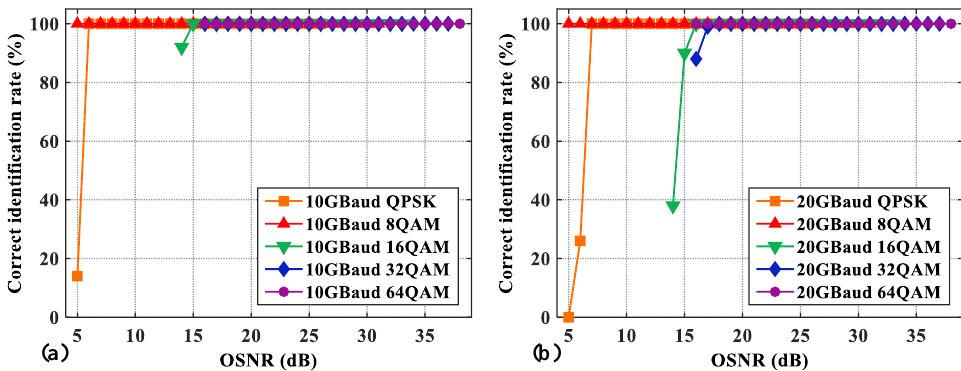
Figure 13. Simulation results of correct identification rate versus OSNR value, under different baud rate: ( a ) 10 GBaud; ( b ) 20 GBaud. Table 2. Amplitude value and associated probability for each level of PS-16QAM and PS-64QAM signals.